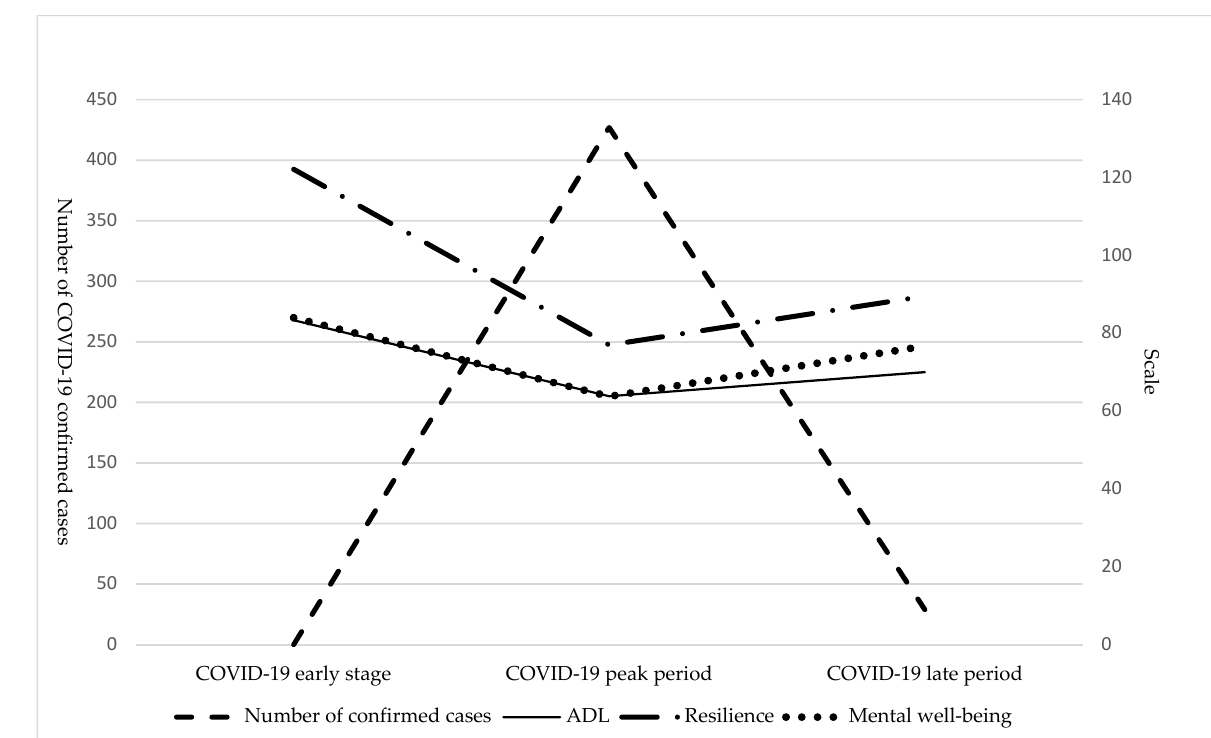
Figure 1. Number of confirmed COVID-19 cases in Taiwan and activities of daily living, mental well-being, and resilience for the different outbreak periods. At the peak of the outbreak, the activities of daily living, mental well-being, and resilience were significantly lower than during the early and late periods. Correlation analysis confirmed significant negative relationships between the number of COVID-19 cases and the resilience scale (r = − 0.378, p < 0.001), mental well-being scale (r = − 0.438, p < 0.001), and activities of daily living (r = − 0.177, p = 0.04). ADL, activities of daily living.